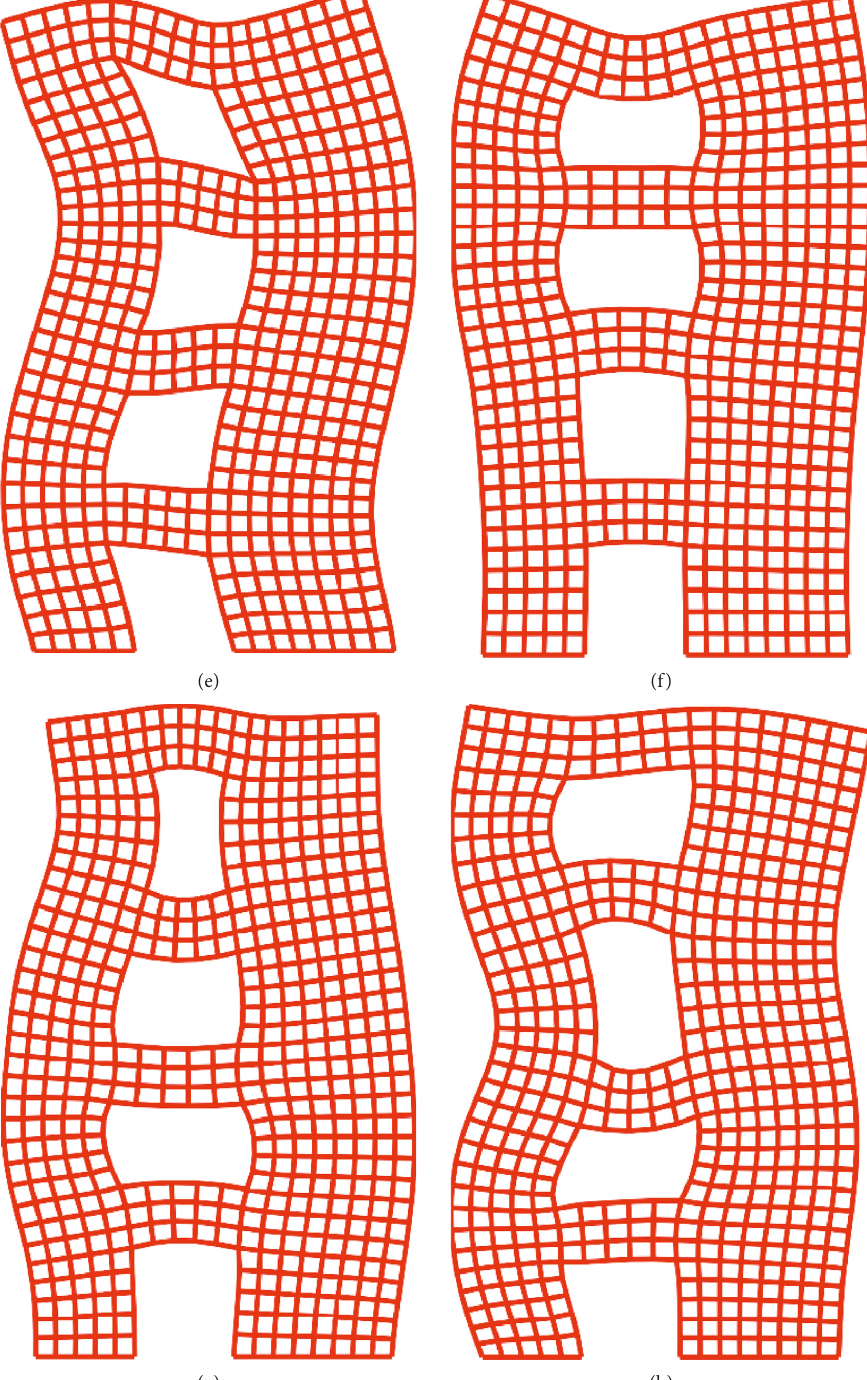
Figure 21: First 8 modeshapes of shear wall with four openings. (a) Mode 1. (b) Mode 2. (c) Mode 3. (d) Mode 4. (e) Mode 5. (f) Mode 6. (g) Mode 7. (h) Mode